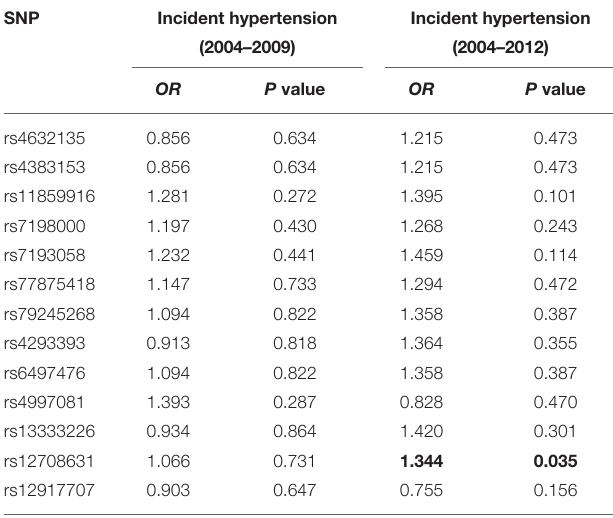
TABLE 3 | Association of UMOD individual SNPs with hypertension